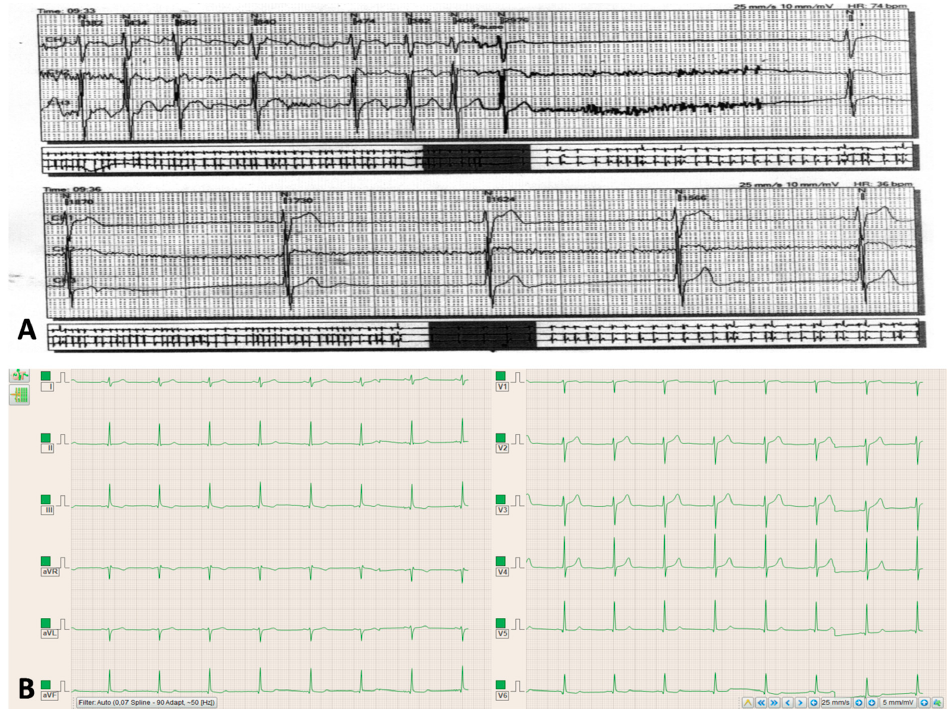
( B ) Electrocardiogram showing the sinus rhythm, benign early repolarization pattern, the increased voltage of the QRS complex, and subtle secondary repolarization changes in lead V6 and the inferior